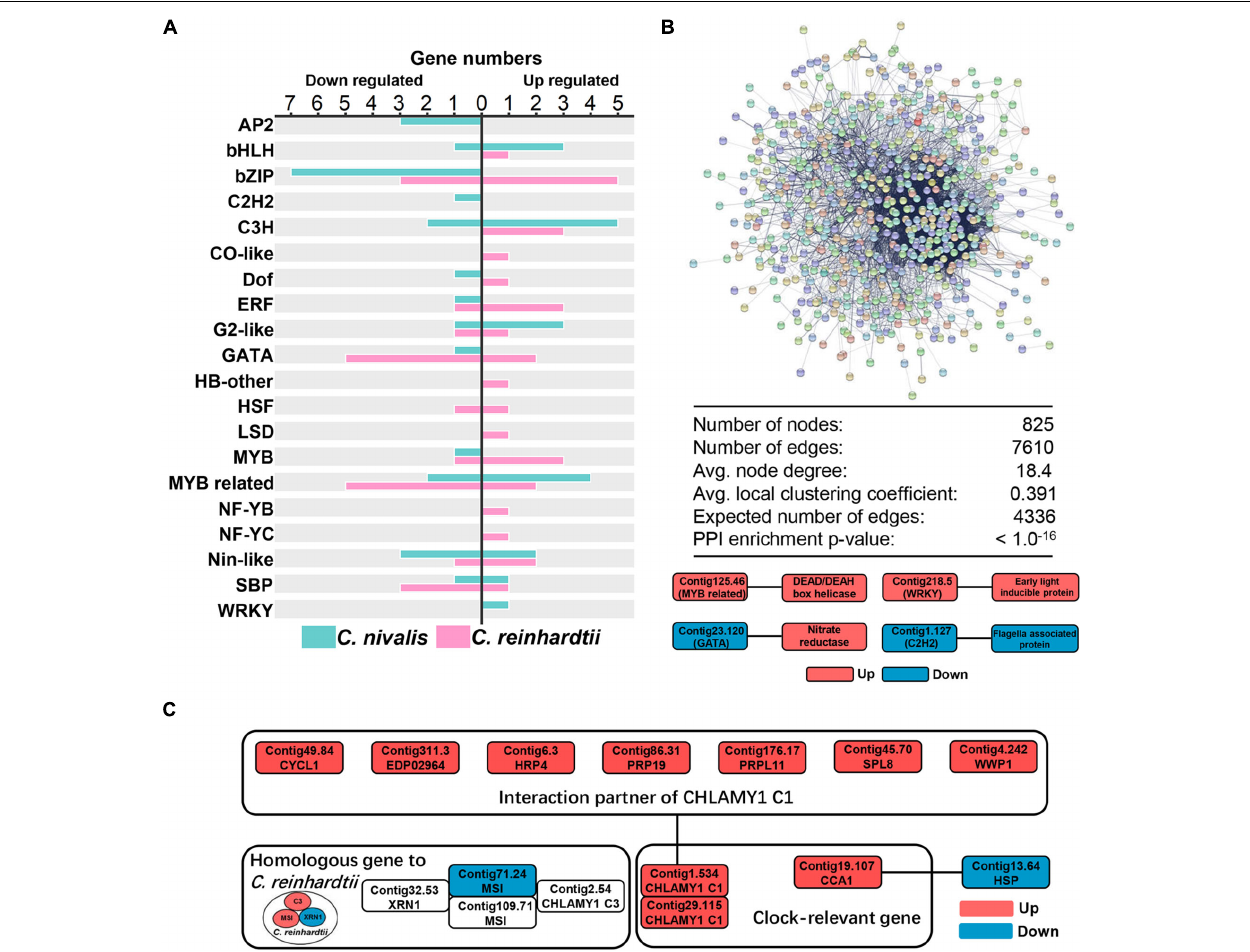
FIGURE 4 | Candidate transcription factors and RNA-binding proteins participate in the cold response of C. nivalis . (A) Numbers of differentially expressed transcription factors in C. nivalis and C. reinhardtii , classified into transcription factor families. For each family, upregulated and downregulated genes are indicated by the direction of the axis. (B) Graph and table (top) showing protein–protein interaction analysis of DEGs in C. nivalis based on STRING database. DEGs are shown as colored circles and named as nodes (colors are used as a visual aid to identify the nodes), and interactions are shown as lines and named as edges. The graph below represents the interaction between differentially expressed transcription factors and genes related to metabolism in C. nivalis . Avg., average. PPI, protein–protein interaction. (C) Interaction network of differentially expressed clock-relevant genes in C. nivalis . Homologous genes differentially expressed in C. reinhardtii are also